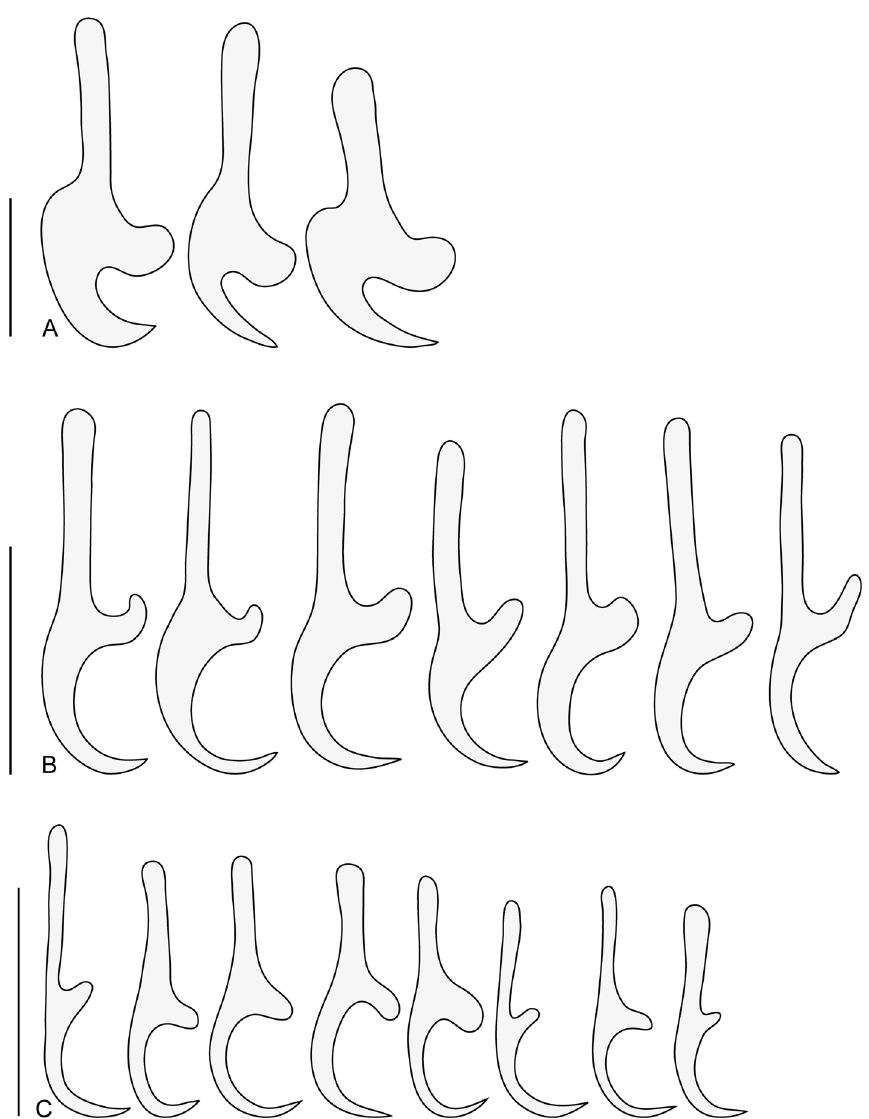
Figure 4. Indopolystoma viridi n. gen. n. sp. from Zhangixalus viridis . Marginal hooklets from paratypes. (A) Marginal hooklet C1; (B) Marginal hooklet C8; (C) Marginal hooklets C2 – C7. Scale bar: 20 l